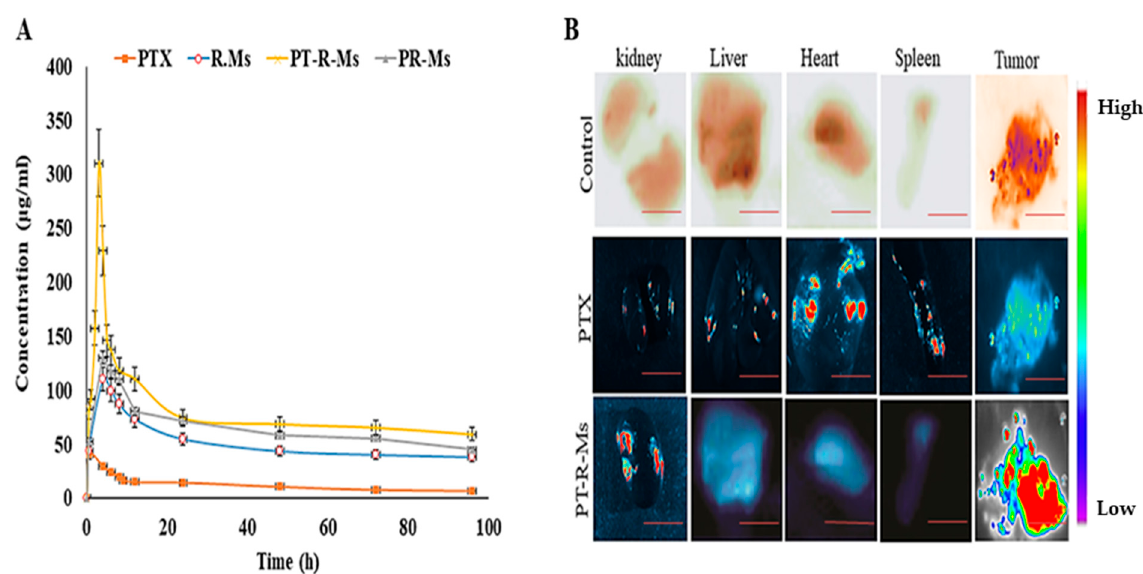
Figure 12. ( A ) Plasma concentration of PTX as a function of time after oral administration of PTX and PTX-loaded R-Ms, PR-Ms, and PT-R-Ms (Oral dose = 20 mg/kg). Blood samples were taken at different time intervals until 96 h and analyzed by the HPLC method for PTX quantification. The results are shown as mean ± SD ( n = 3). ( B ) Biodistribution analysis of orally administered pure PTX and fluorescent probe labeled PT-R-Ms in mice organs along with the excised tumors. The scale bar is 20 µm.